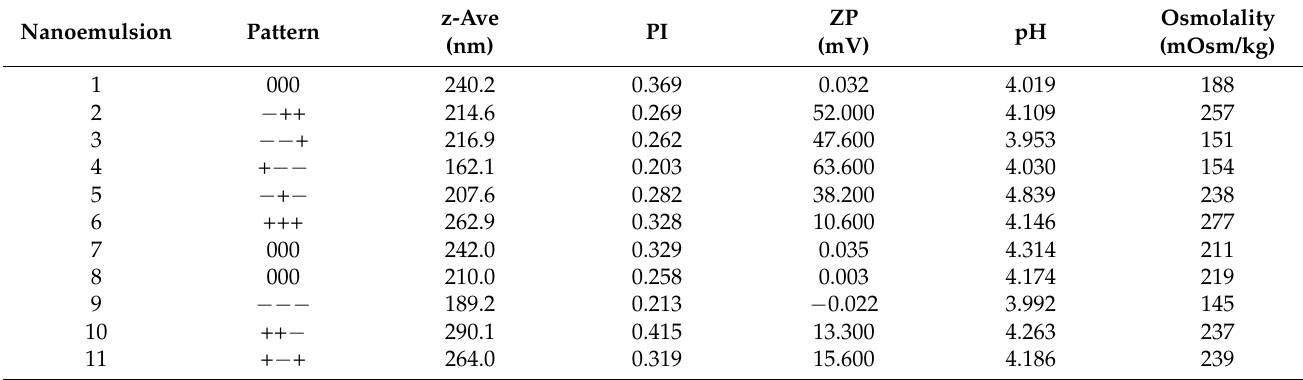
Table 3. Response dependent variables and pH and osmolality of the three independent factors presented in Table 2 for all the 11 produced NEs (Captions: z-Ave, mean particle size; PI, polydispersity index; ZP, zeta